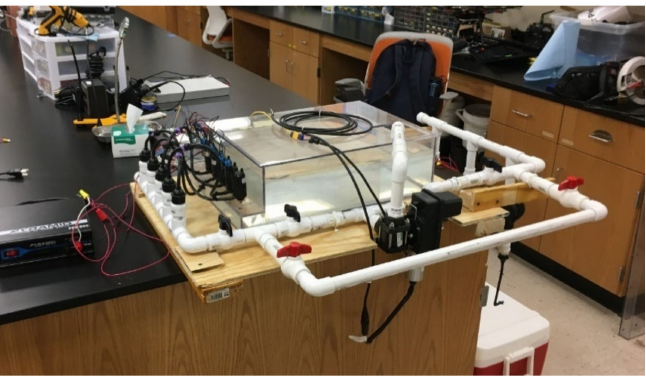
Figure 2. The scaled applicator system used to integrate the Raven flow meter with an